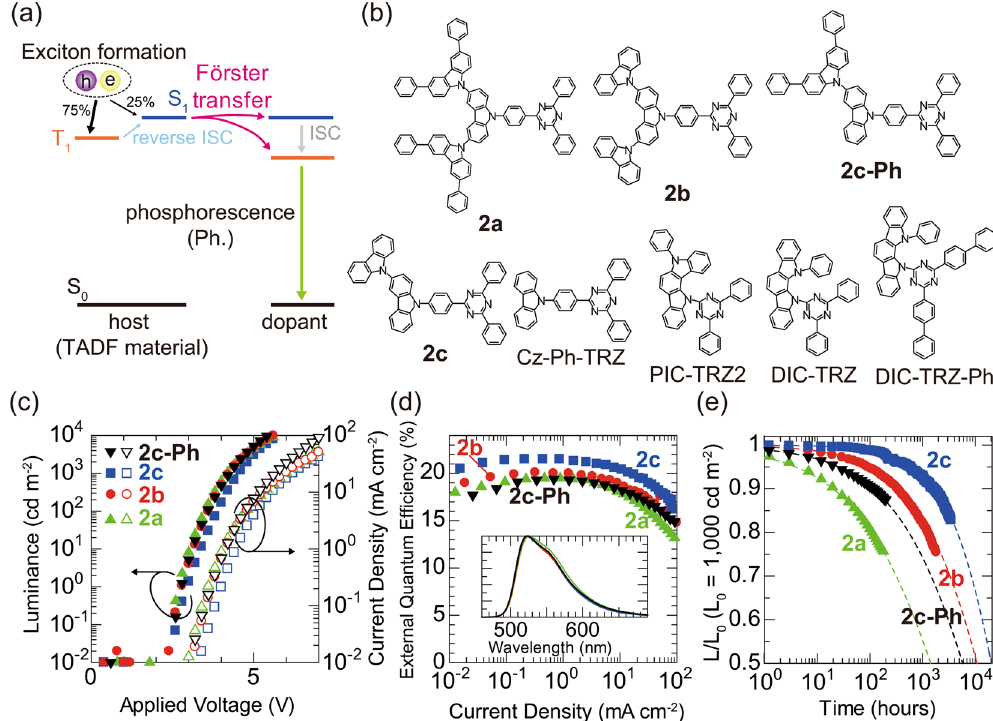
Figure 1. Schematic illustration of the energy transfer process and device performances of OLEDs. ( a ) Energy transfer process from the TADF host to phosphorescent emitter dopant. ( b ) Molecular structures of the host materials used in this study. ( c ) Luminance (left, filled symbols)- and current density (right, open symbols)-voltage characteristics of PHOLEDs. ( d ) EQE-current density curves of PHOLEDs. Inset: EL spectra of PHOLEDs. ( e ) Luminance-time characteristics for devices under a constant dc current with an initial luminance of 1,000 cd m − 2